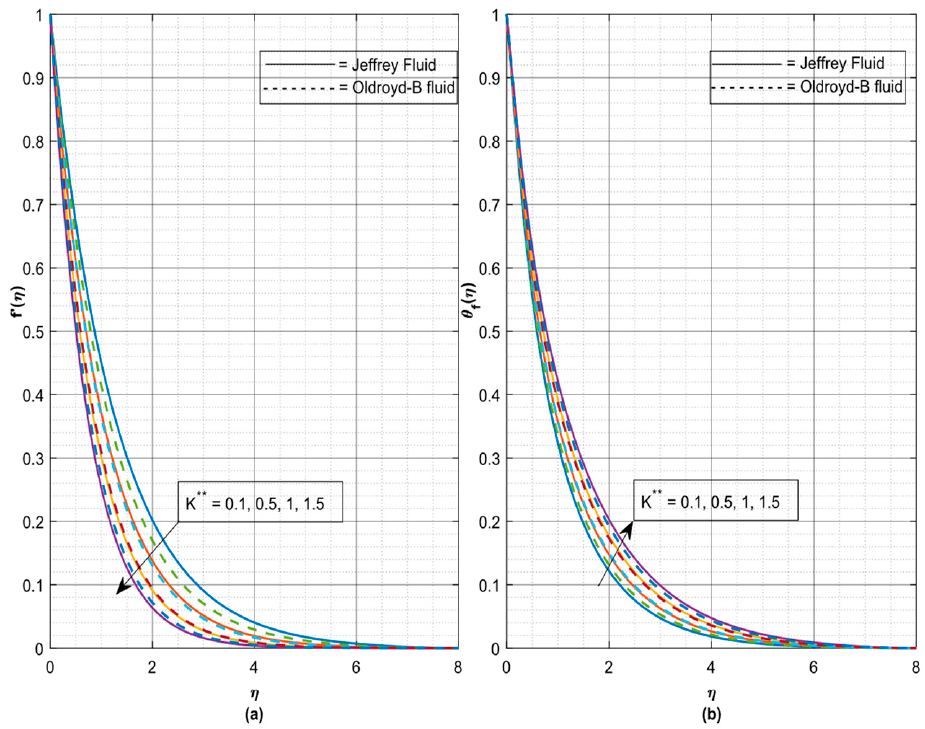
Figure 2. ( a ) Effect of K ∗∗ on f (cid:48) ( η ) , and ( b ) effect of K ∗∗ on θ f ( η ) .